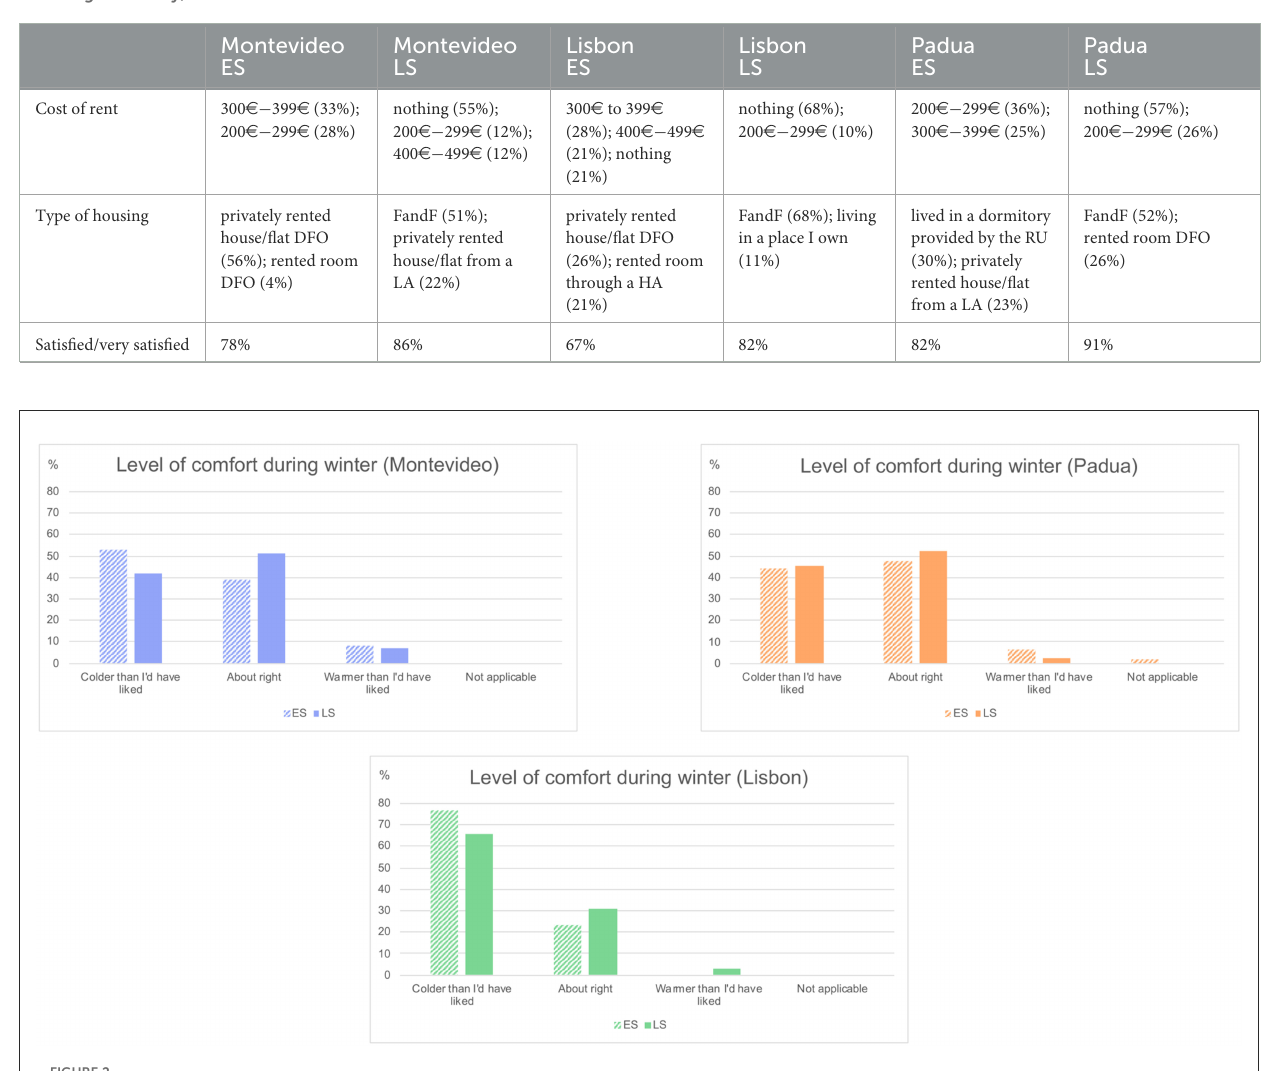
FIGURE2 Perception of energy comfort during winter of ES and LS of Montevideo, Lisbon, and Padua.